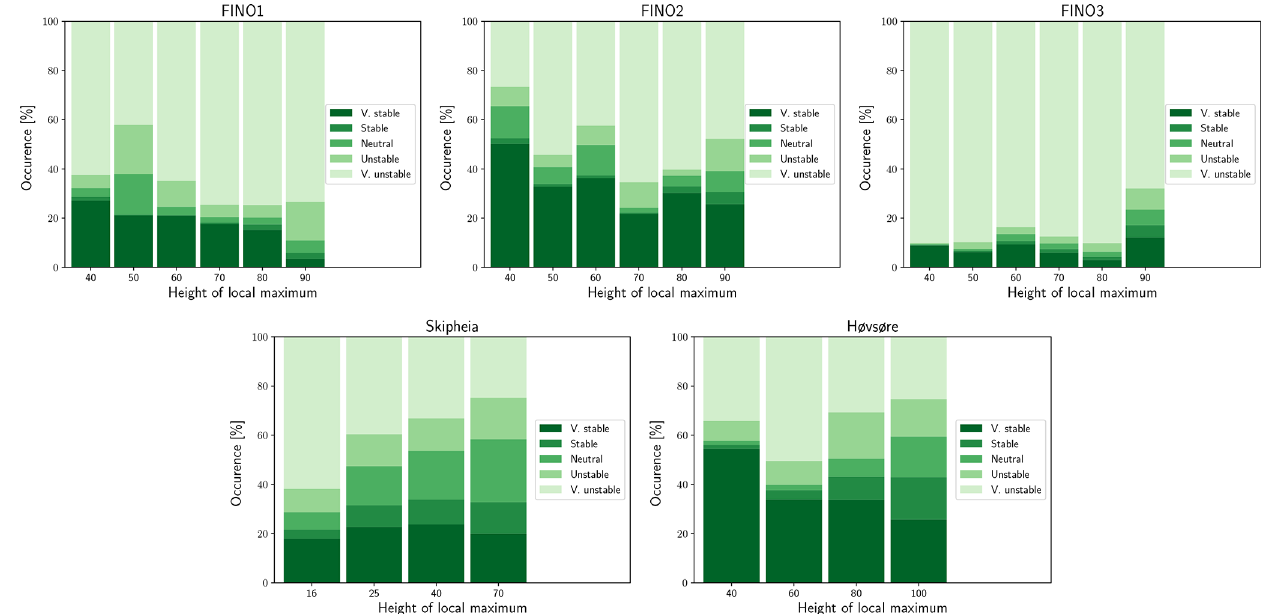
Figure 9. Stability distribution of 1-inflection profiles with varying height of inflection at the five sites which had measurements enabling this analysis.